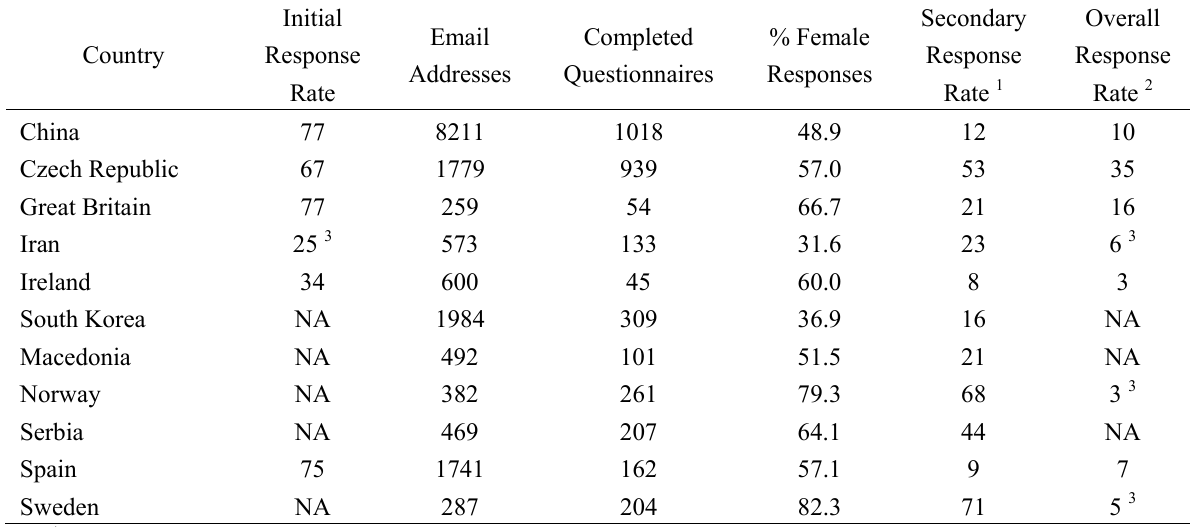
Table 1. Response rates from individual